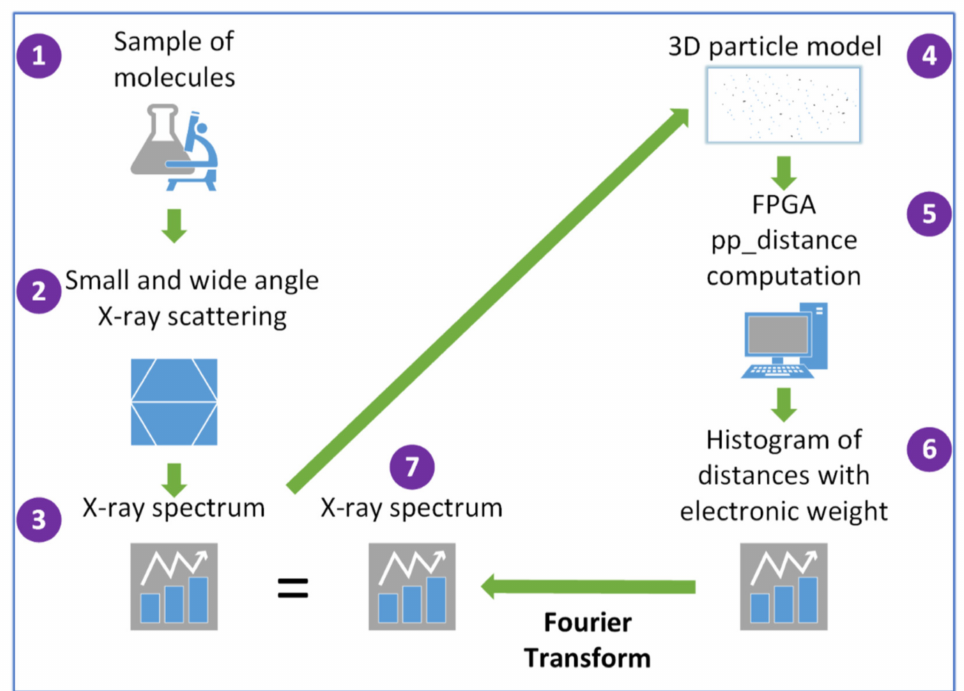
Figure 1. Flow chart for comparison of observed X-ray spectra with model spectra generated using field-programmable gate-array (FPGA) boards to solve the particle–particle (pp) distance problem. The numbers within the figure indicate the